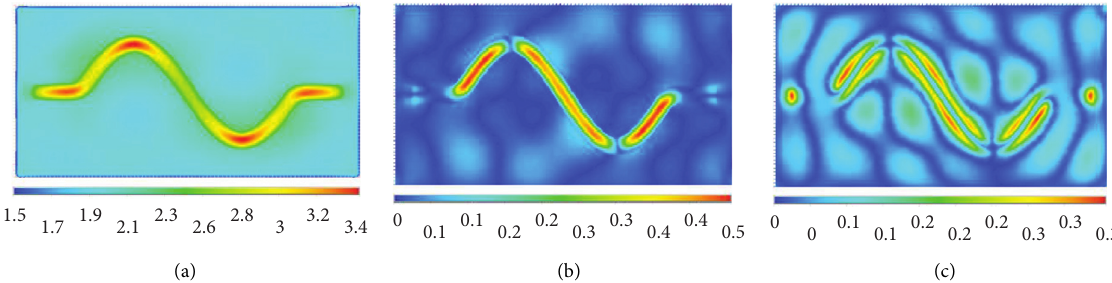
Figure 32: SV wave incident ( H � 125m, f � 1.5Hz, C